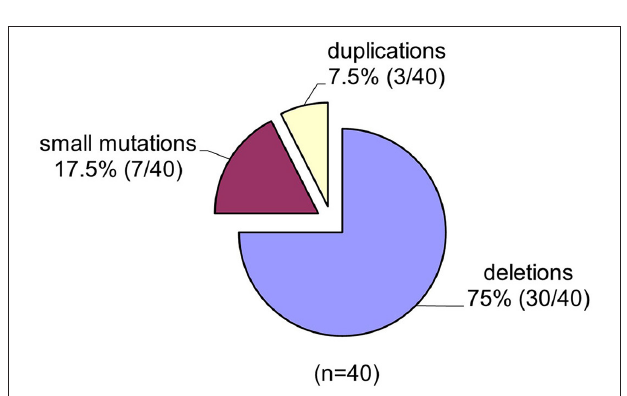
FIGURE 3 | The spectrum of mutations identified in the DMD gene in the group of 40 unrelated Romanian patients.